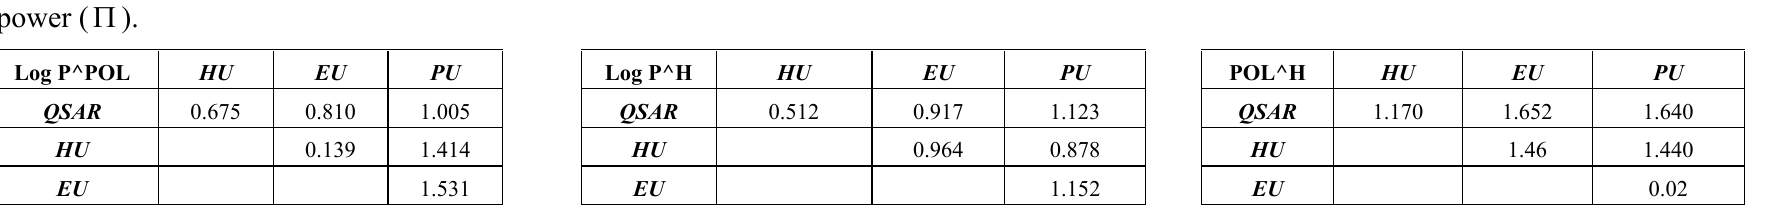
 of the QSAR and catastrophe models’ relative statistics of Table 6 II